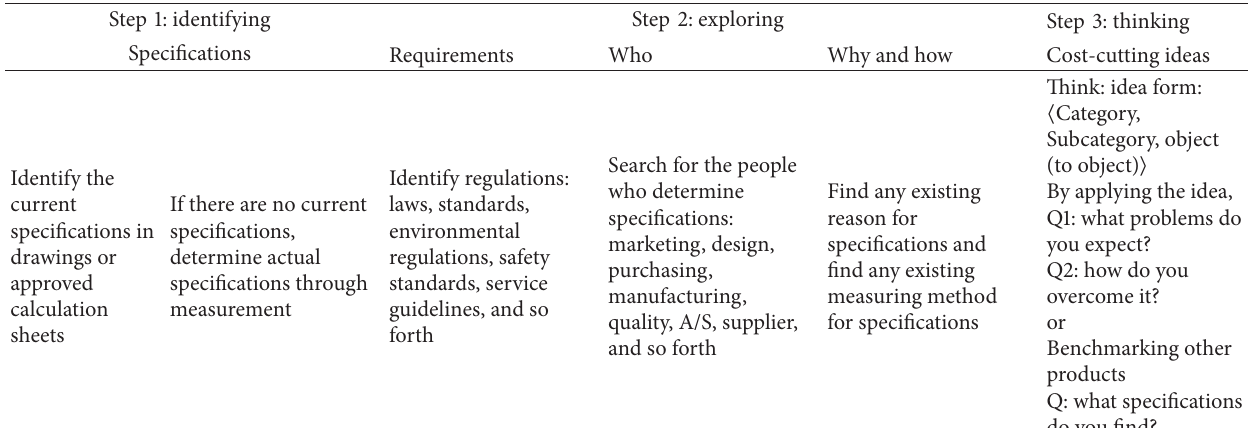
Table 9: Specification review